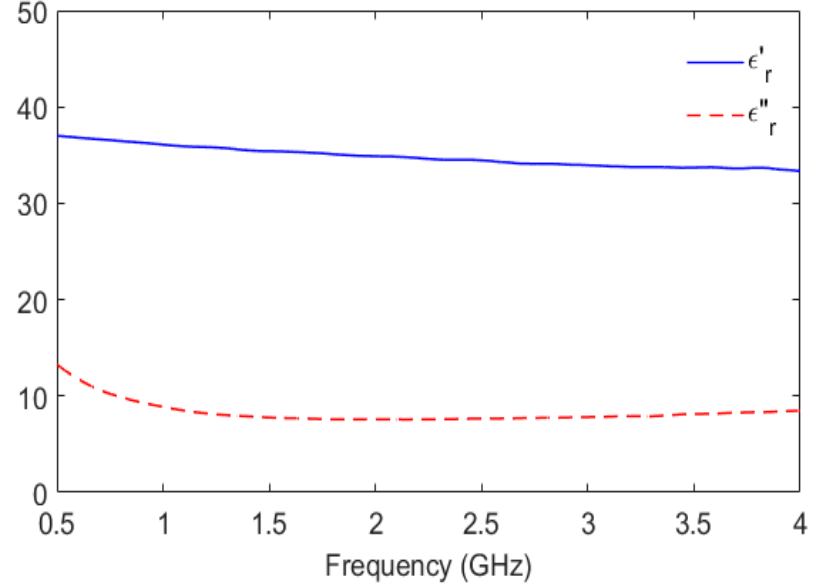
Figure 18. The complex relative permittivity of natural latex over the frequency range of 0.5–4.0 GHz at the temperature of 25 °C.